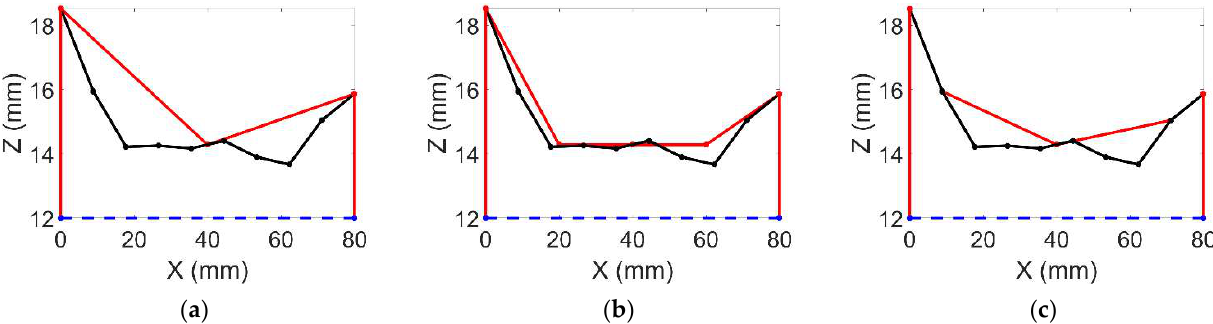
Figure 5. Sample part surface approximation using: ( a ) triangular approach; ( b ) trapezoidal approach and ( c ) hybrid approach. Height profile is shown in red, desired Z height is shown by the dotted blue line, and higher fidelity height profile is shown in black. Note that the higher fidelity height profile overlaps the hybrid surface approximation at the ends of the wall profile.